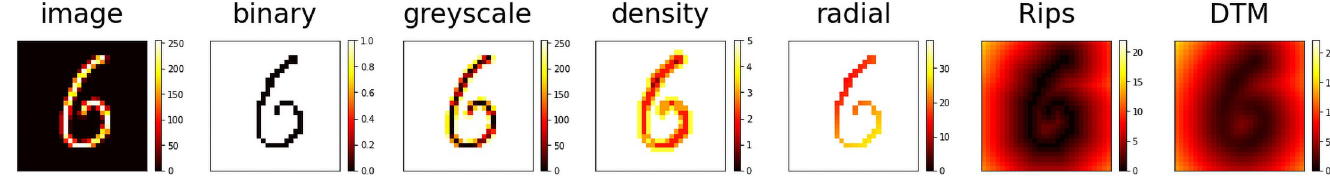
Fig 3. Filtrations. The first plot shows an example MNIST image Z , with greyscale pixel values in [0, 250]. The next four plots respectively show the heat map for the binary, greyscale, density and radial filtration function � : K ð Z Þ ! R ; where K ( Z ) is the cubical complex corresponding to the given example image. The final two plots visualize the heat map of � : K ð Z Þ ! R ; where ϕ is the discretized version of the Rips and DTM filtration functions d X ( Z , z 0 ) is the point cloud corresponding to the image Z